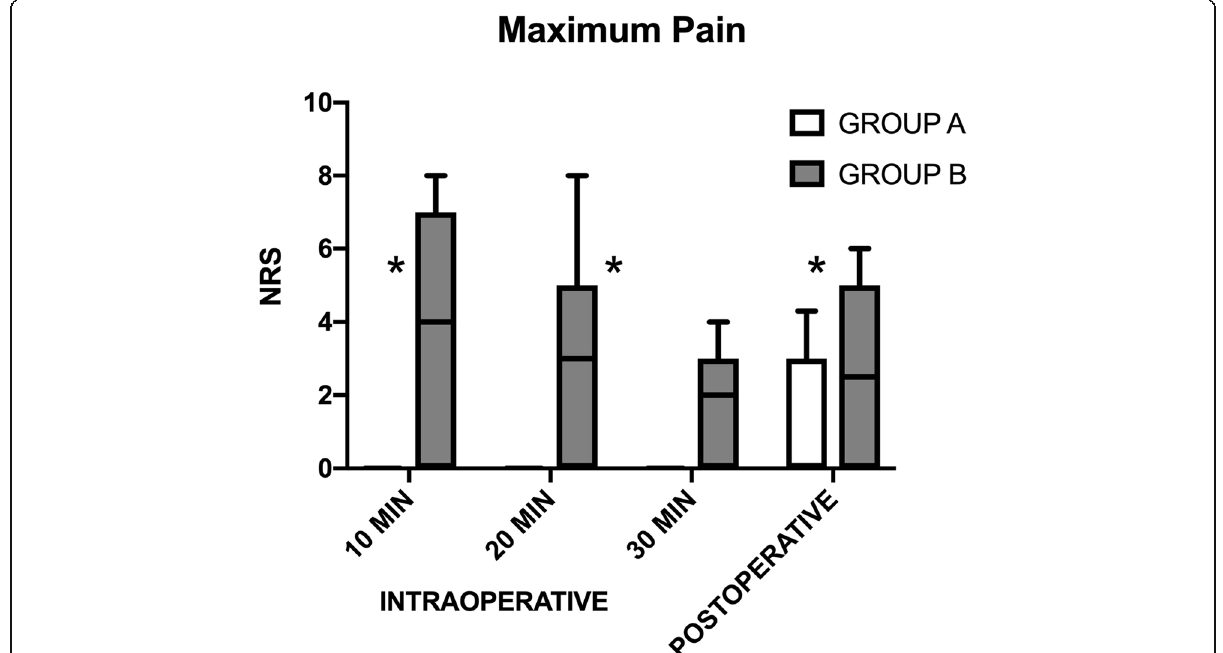
Fig. 2 Perioperative Pain. The box plot shows pain scores during and after surgery performed by unilateral spinal anesthesia with hyperbaric prilocaine (Group A) vs. local anesthesia performed by surgeon (Group B). Data include maximum pain reported in a 0-10 Numeric Rating Sale, measured both intra and postoperatively. Postoperative values were recorded in PACU at 60 minutes after the end of surgery. Values are expressed as mean (horizontal bars) with 25th – 75th (box) and 10th – 90th (whiskers); *denotes statistical significance ( p < 0.05); NRS: Numeric Rating